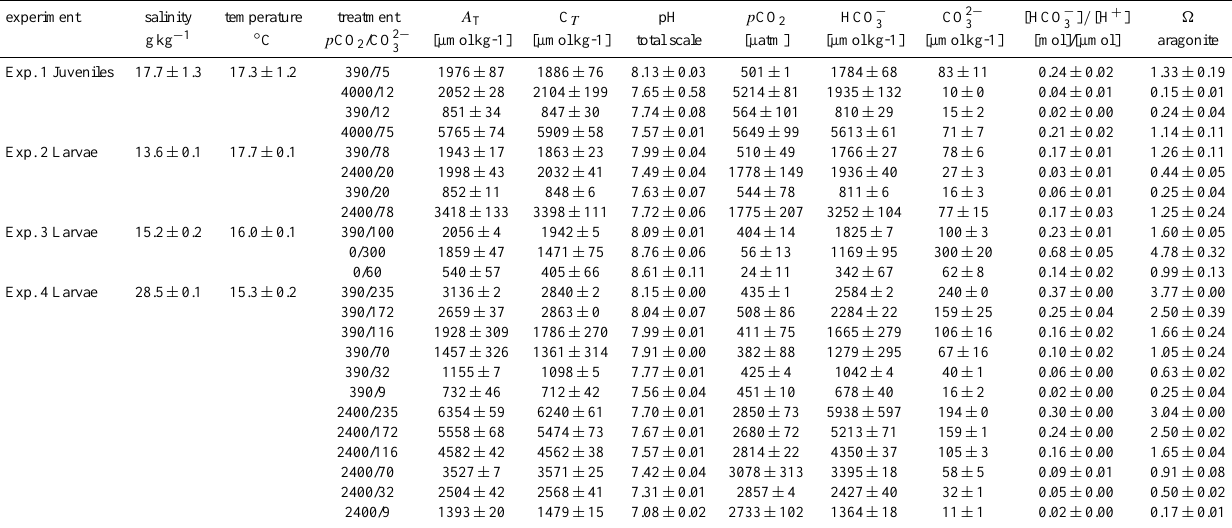
Table 1. Carbonate chemistry parameters of the four experiments (mean ± SD) calculated from measured C T (larval experiments) or A T (juvenile experiment) and pH (NBS or total